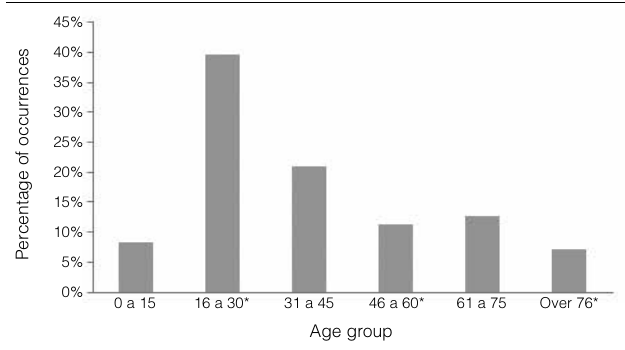
g a cen t r P e